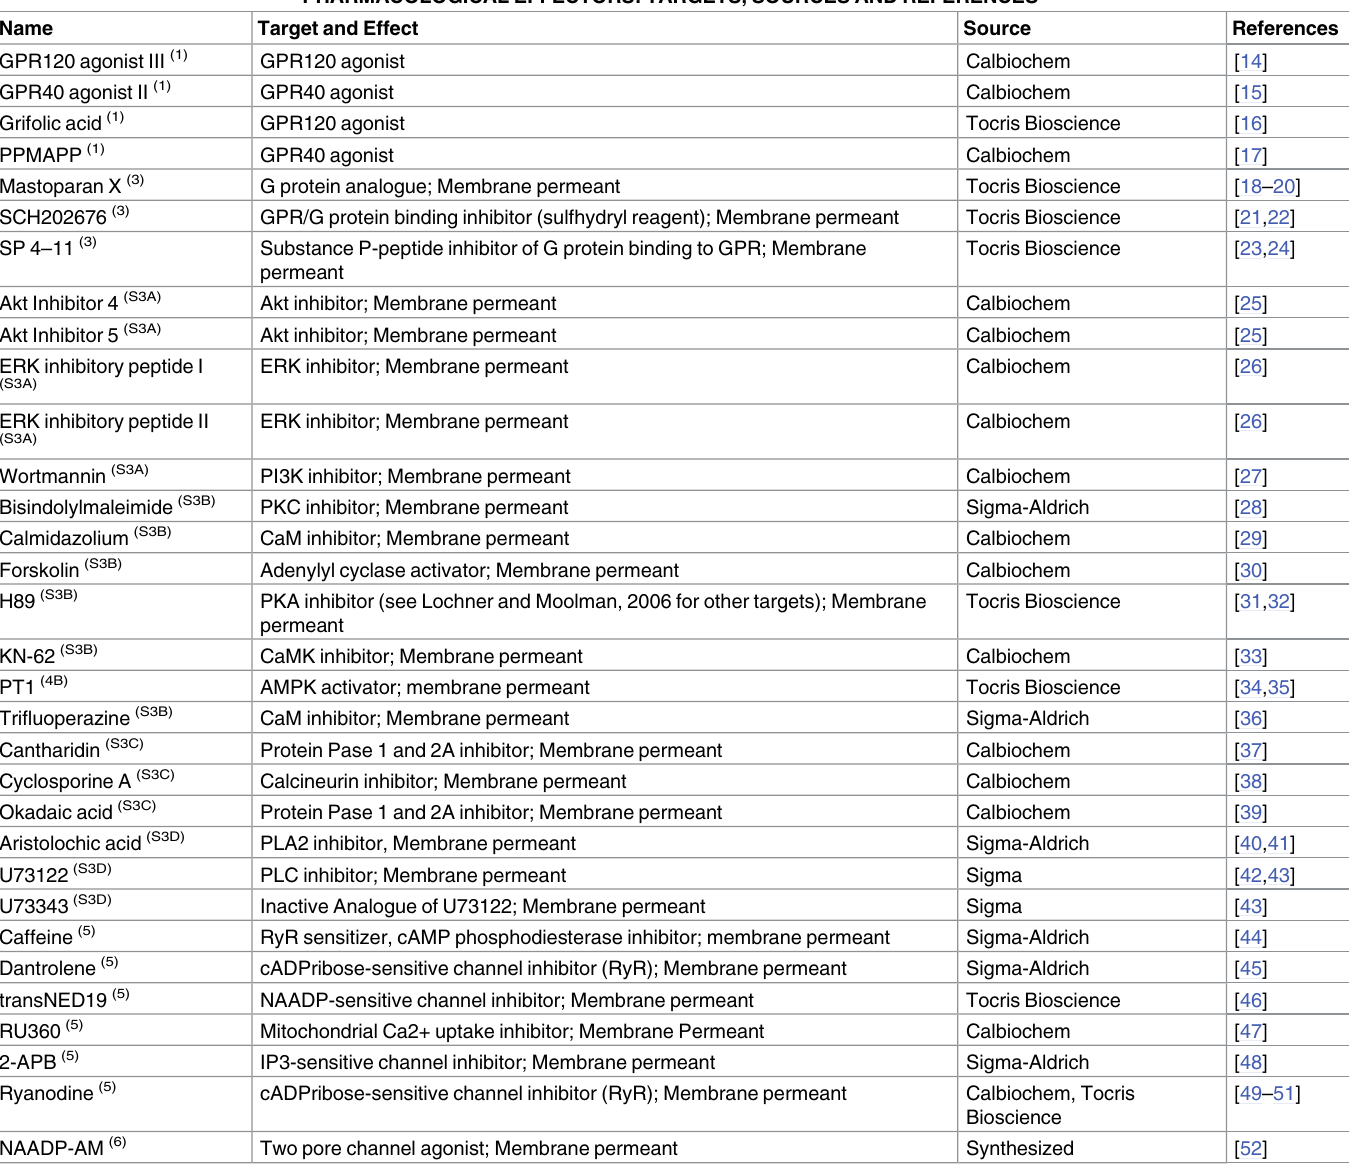
Table 1. Pharmacological